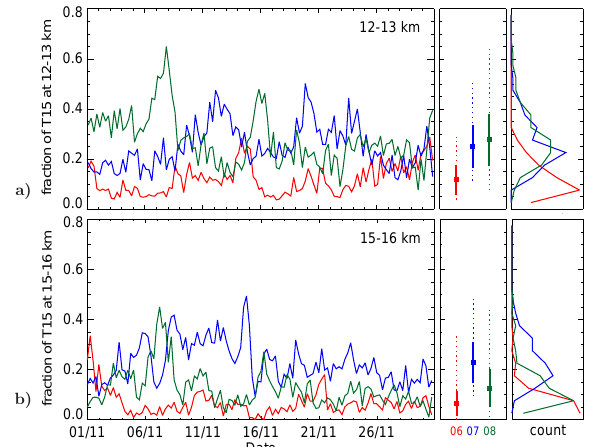
Fig. 7. Plot (a) shows a timeseries of the fraction of T15 (a CHBr 3 like tracer) relative to an initialisation value at 1km that reaches an altitude of 12–13km above Borneo for the Novembers of 2006–2008. A statistical summary is provided by (1) the “box and whisker” plot to the right, with the monthly mean marked with a square, the bold lines denoting ± 1 standard deviation, and the dot- ted line representing the range and (2) a probability distribution to the far right (bin size 0.05). Plot (b) provides the same information, but for an altitude of